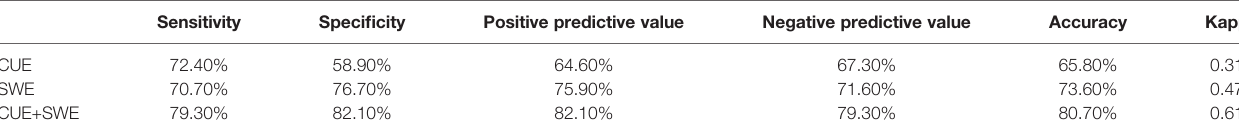
TABLE 3 | Comparison of diagnostic ef fi cacy of CUE, SWE, and their conjunctive use in ANM. Sensitivity